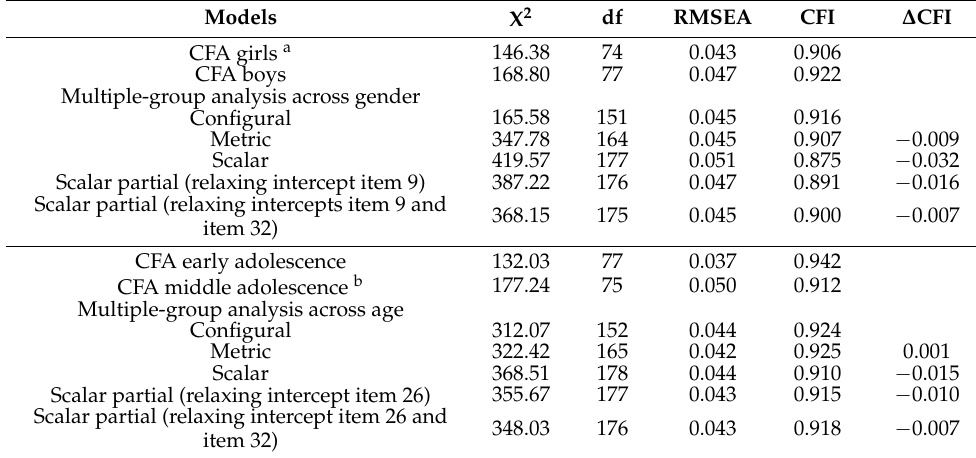
Table 2. Multi-group analysis for MD (1 factor and 14 items) across gender and